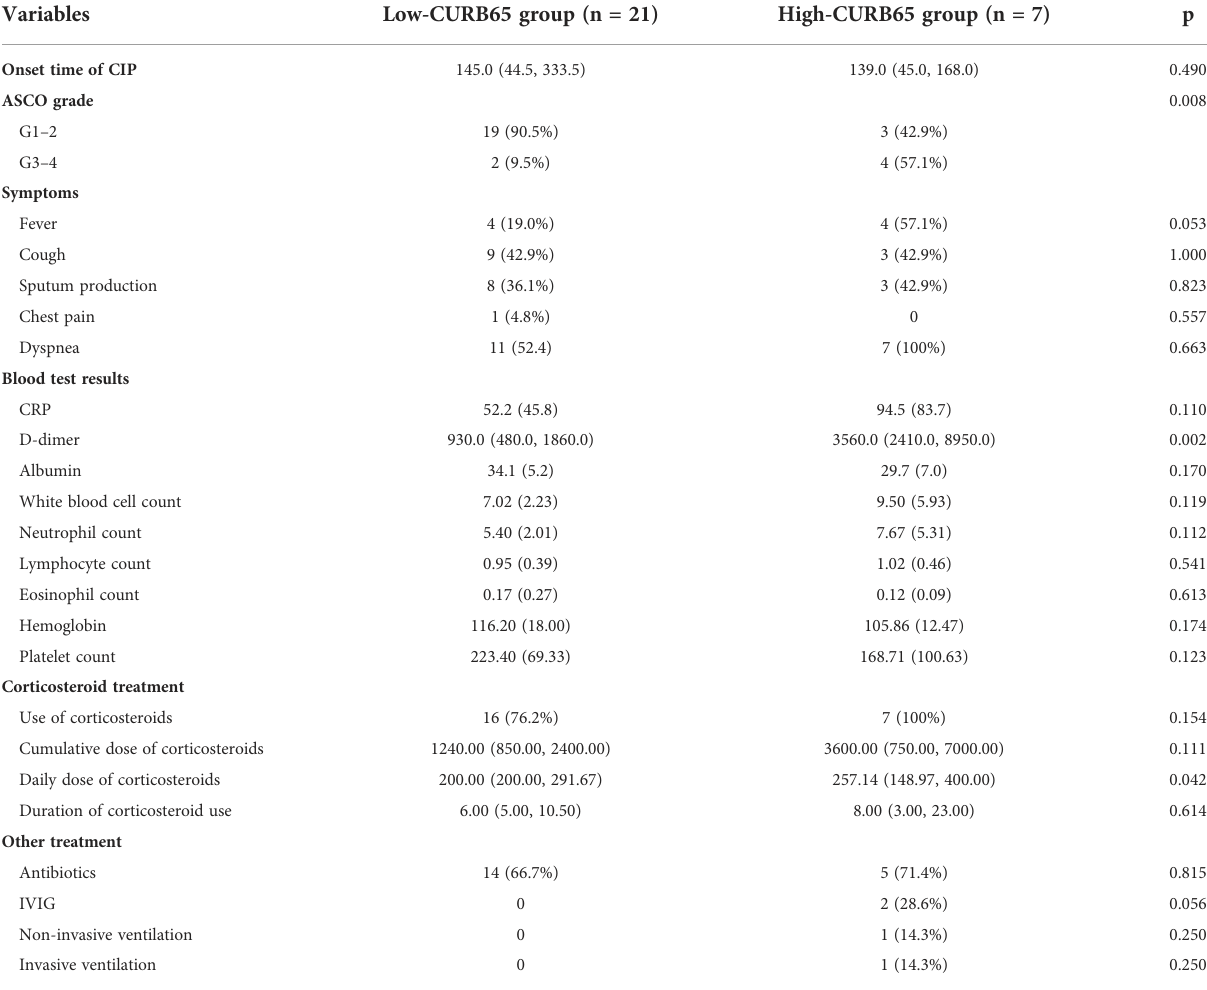
TABLE 3 CIP characteristics and treatment.